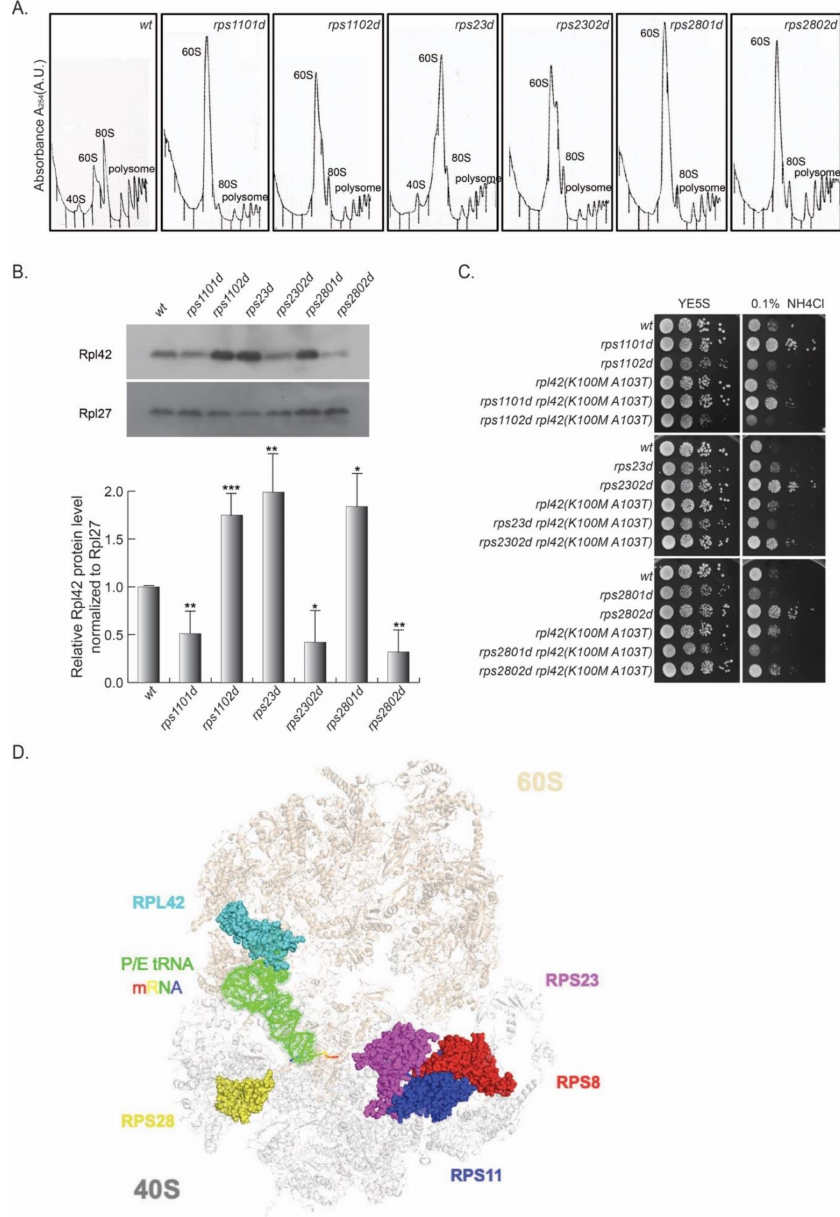
Figure 4. The differential Rpl42/eL42 protein level can also be detected in other 40S paralog deletions. ( A , B ) Comparison of the Rpl42/eL42 protein level between rps11, rps23, and rps28 paralog deletions by polysome analysis and Western blotting. Compared with wild − type cells, there were higher levels of Rpl42p/eL42 in rps1102d, rps23d, and rps2801d cells than in rps1101d, rps2302d, and rps2802d cells. p − values were obtained by the two − tailed Fisher’s exact test. * p < 0.05; ** p < 0.01; *** p < 0.005. ( C ) rpl42 also has specific genetic interactions with the rps11, rps23, and rps28 genes. By introducing the rpl42 (K100M A103T) mutation into the rps11, rps23, and rps28 paralog deletion strains, the phenotype of enhanced growth in the presence of excess NH 4 Cl of rps1101d, rps2302d, and rps2802d was reversed, similar to what was observed in rps802d cells. ( D ) Top view of the Saccharomyces pombe 80S ribosome in a complex with P/E site tRNA (green) and mRNA (rainbow). Rps8/eS8 (red), Rps11/uS17 (dark blue), Rps23/uS12 (purple), Rps28/eS28 (yellow), and Rpl42/eL42 (light blue) are shown in a transparent space-filling mode, while the large (60S) and small (40S) subunits are shown in brown shading and blue shading,